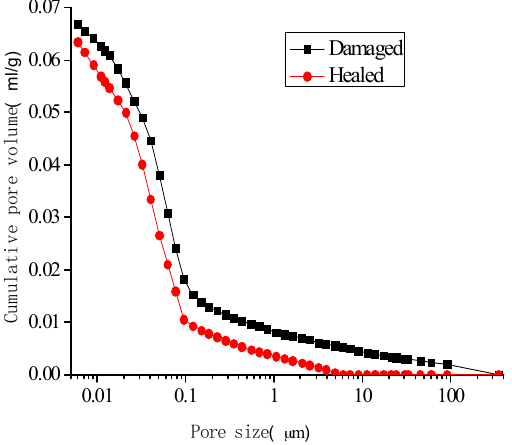
Figure 15. Cumulative-pore volume distribution for specimens with 3% microcapsules.